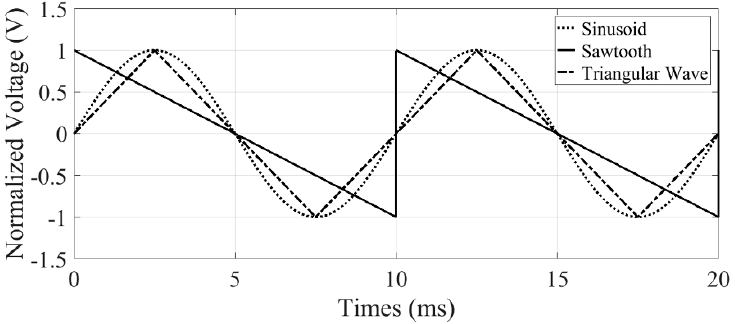
Figure 7. Two periods of the three modulation signals.